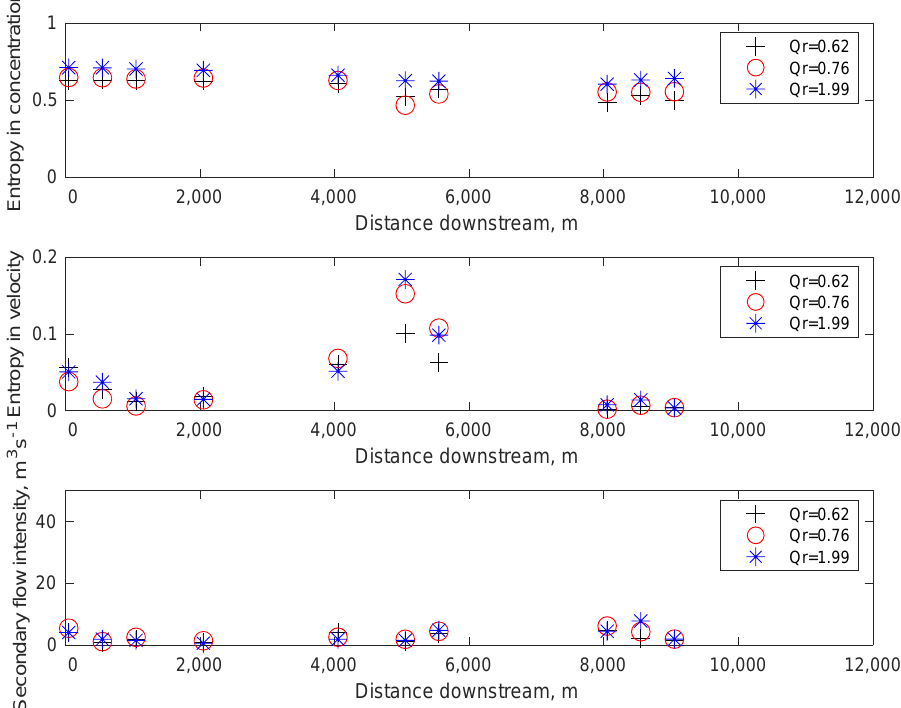
Figure 8. Longitudinal distribution of entropy of concentration, entropy of velocity and secondary flow intensity for di ff erent values of the discharge ratio for the P simulations.